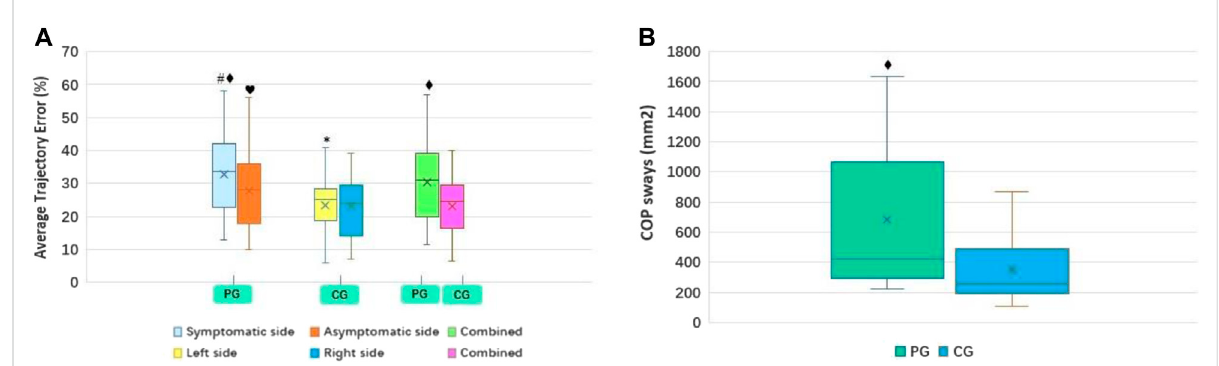
FIGURE 5 PG and CG differences in ATE (A) and COP sway areas (B) . PG, patient group; CG, control group. ATE, average trajectory error; COP, the center of pressure. Compared to contralateral, # p < 0.01; Compared to contralateral, * p > 0.05; Compared to CG, ◆ p < 0.01; Compared to CG, & p < 0.05.